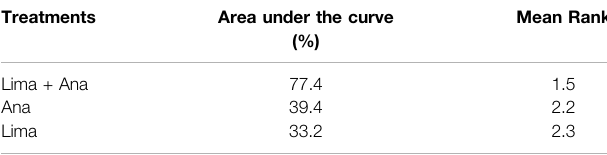
TABLE 6 | Area under the curve and the mean rank for EQ-5D. Treatments